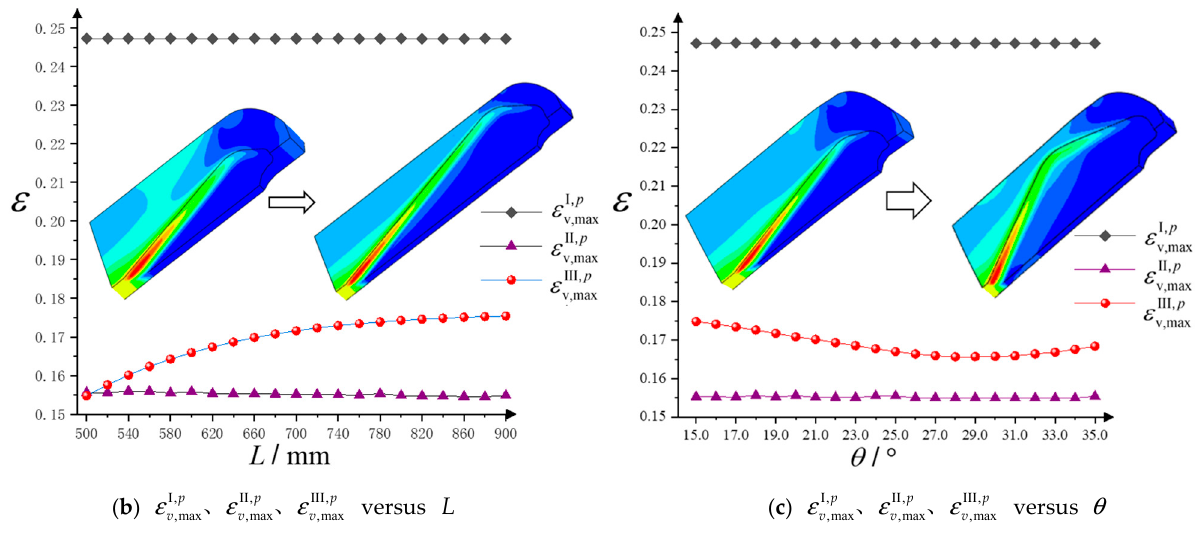
Figure 11. The relationship map